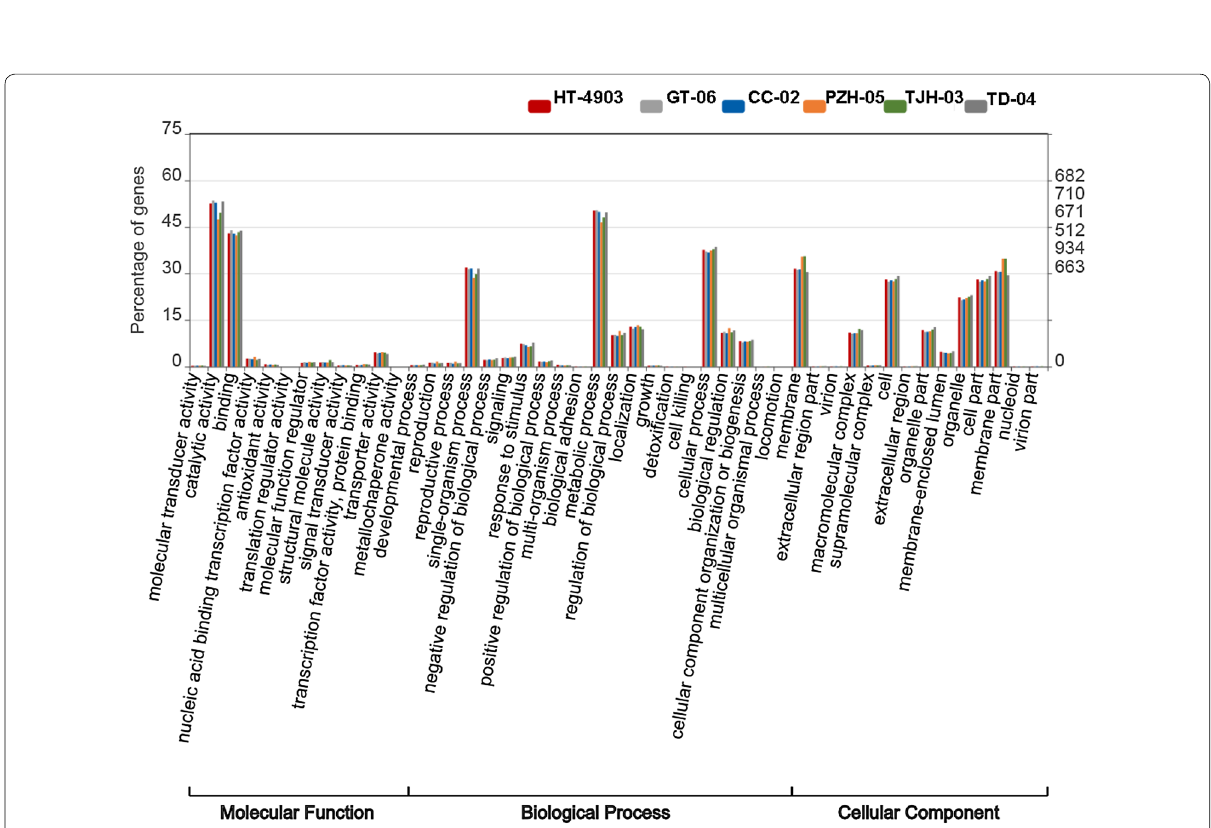
Fig. 2 GO classification of unigenes in the six H. erinaceus